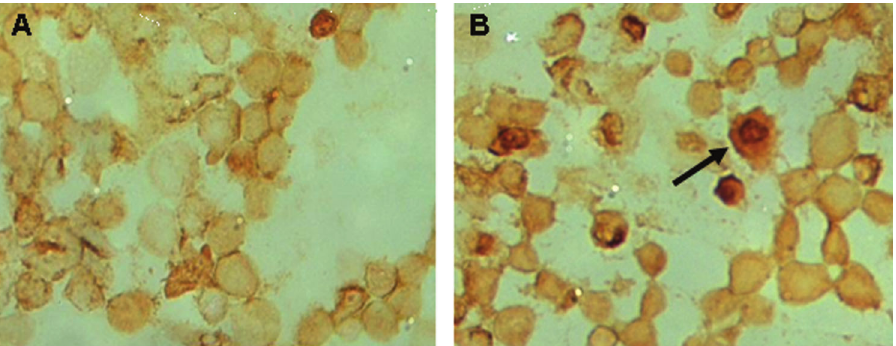
Figure 2 - Comparison of the morphology of WRL68 and HepG2 cells before and after treatment with 2 mg/ml Chlorella vulgaris extract. Apoptotic cells are absent in untreated WRL68 cells (a) and in treated (2 mg/ml C. vulgaris ) WRL68 cells (b). Apoptotic cells are absent in untreated HepG2 cells (c), but present in treated (2 mg/ml C. vulgaris ) HepG2 cells (d). Arrow shows condensation of chromatin and cell blebbing on HepG2 cells.